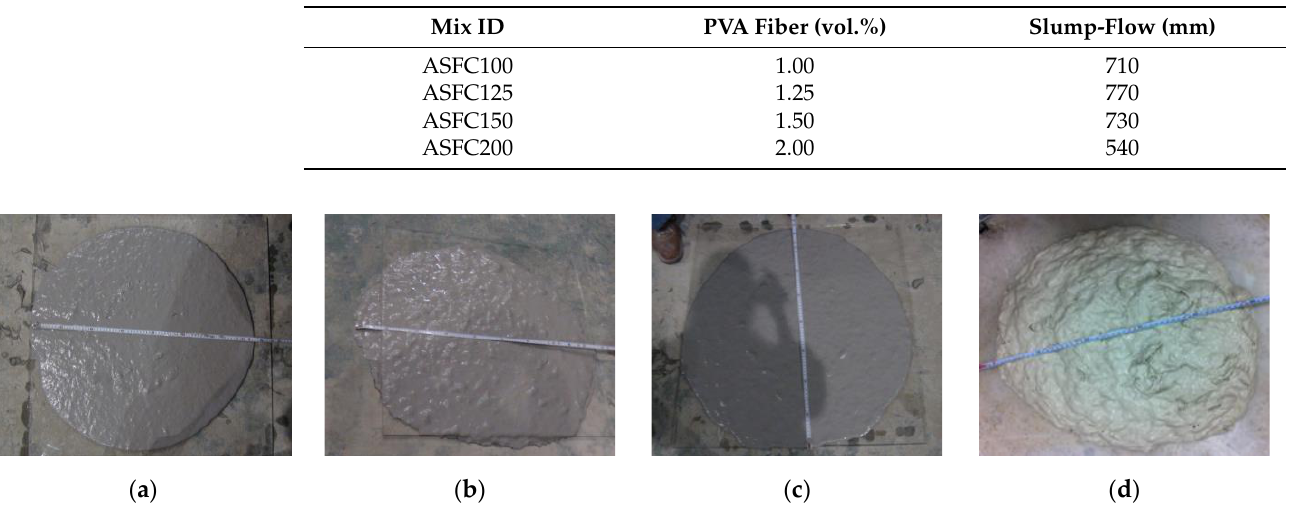
Figure 1. Slump-flow test: ( a ) ASFC100; ( b ) ASFC125; ( c ) ASFC150; ( d ) ASFC200.